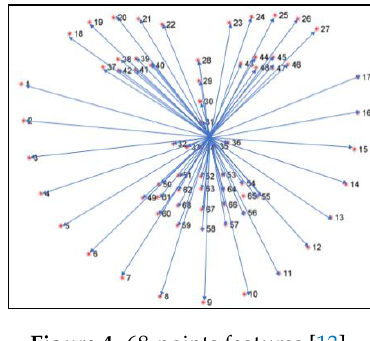
Figure 4. 68-points features [13].